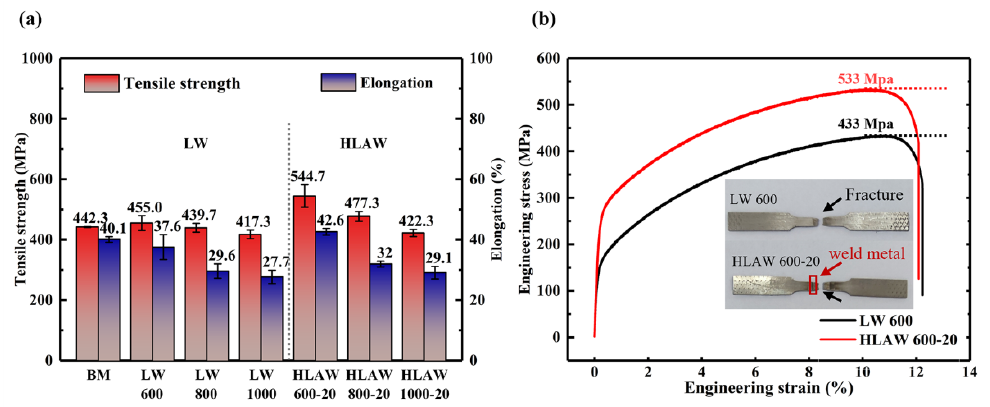
Figure 11. Tensile properties of different joints: ( a ) tensile strength and elongation; ( b ) σ - ε curves of the LW and HLAW joints.